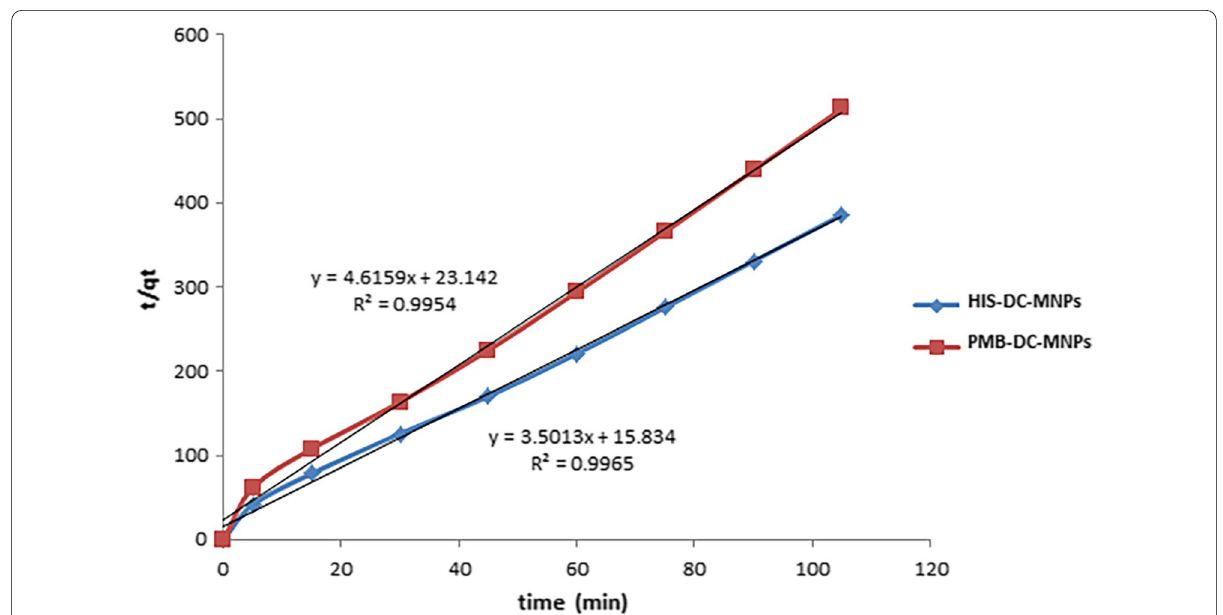
Fig. 9 Pseudo‑second‑order kinetics for histidine and PMB